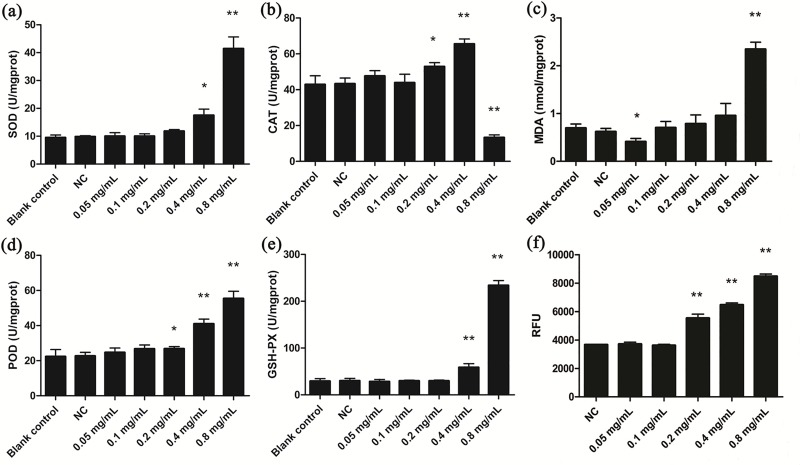
Antioxidant indices for T. thermophila exposure to koumine.(a) SOD (b) CAT (c) MDA (d) POD (e) GSH-PX (f) ROS, results were expressed as relative fluorescence unit (RFU) values. Results were expressed as mean ± SD (n = 3). * indicates significant differences (P < 0.05), ** indicates highly significant differences (P < 0.01). All treatment groups were compared to the NC group.